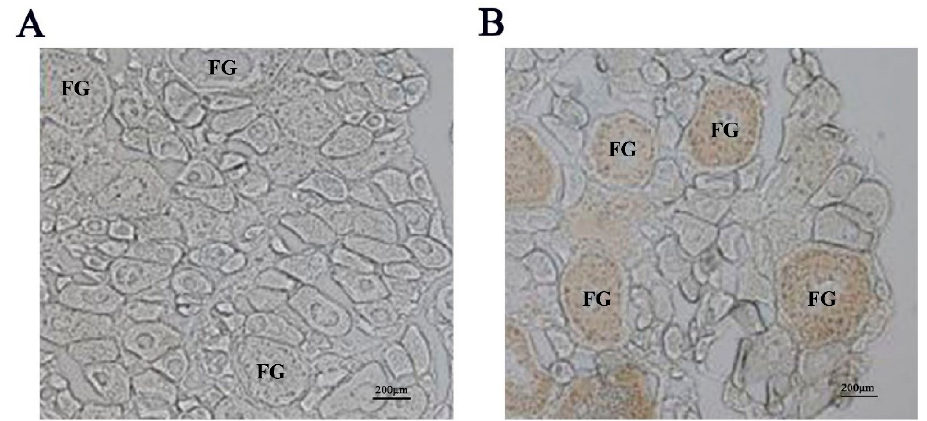
Figure 2. Immunohistochemical detection of Igf3 in E. coioides ovarian tissues. ( A ) negative control lacking primary antibody. ( B ) Igf3-specific polyclonal primary antibody. Note: FG indicates full grown stages of follicular.